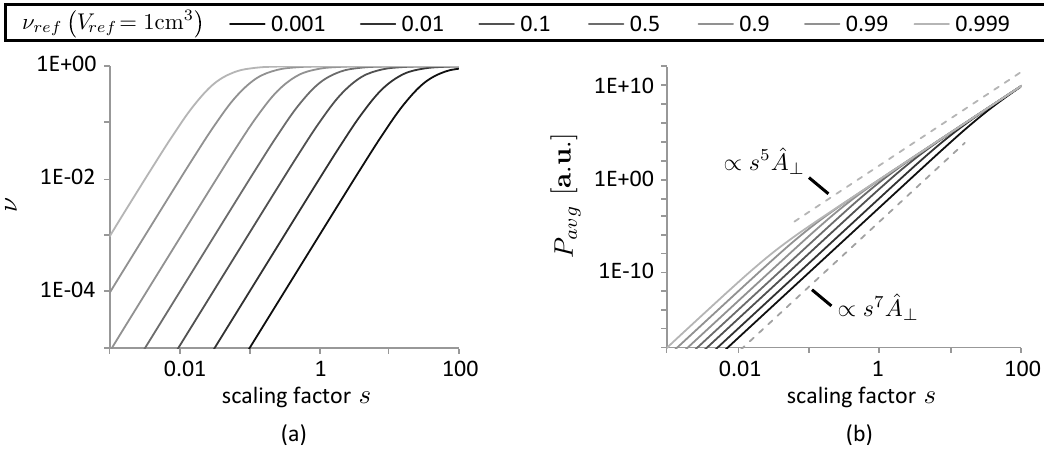
( a ) conversion effectiveness ν with respect to scaling factor s according to Equation (6) and ( b ) average power P at the eigenfrequency according to Equations (5) avg and (10) for different ν ( V = 1 cm 3 ) . Dashed lines denote slope of